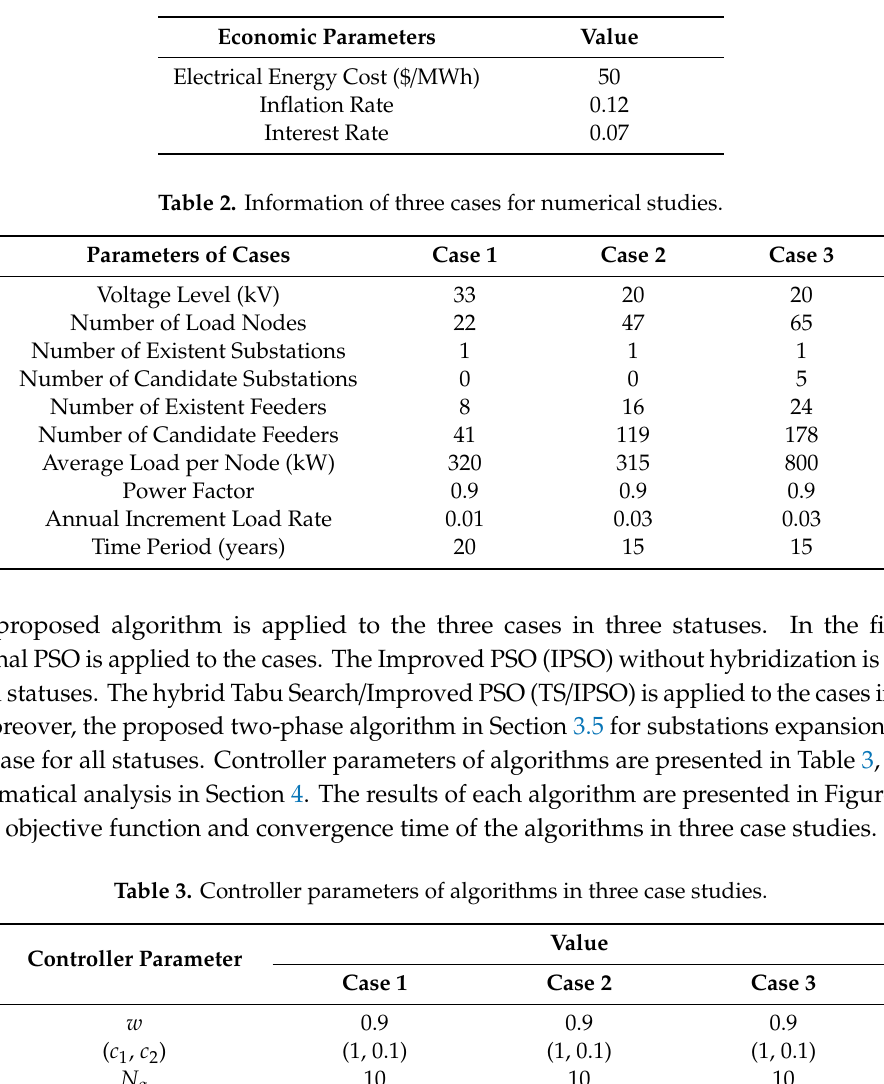
Table 1. Economic data for numerical studies.